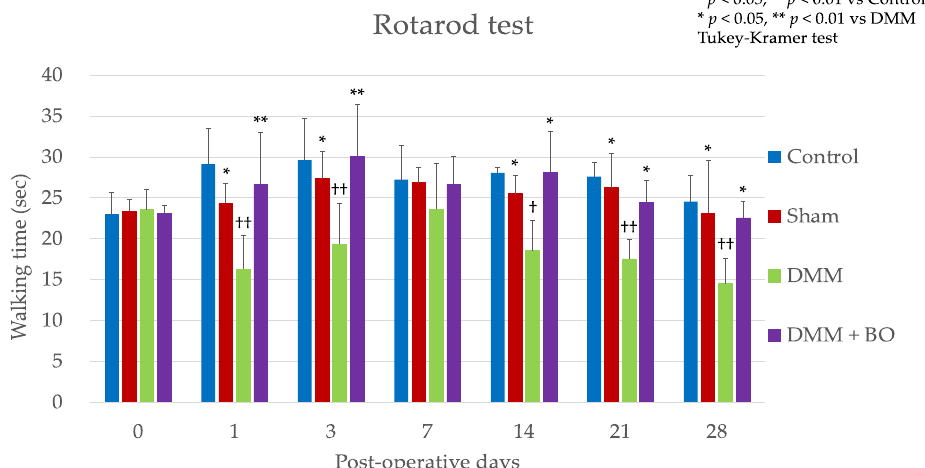
Figure 3. Rotarod test. All data are presented as mean ± standard deviation ( n = 5 per group). † p < 0.05, †† p < 0.01 vs. Control, * p < 0.05, ** p < 0.01 vs. DMM. DMM, destabilization of the medial meniscus; BO, boiogito.